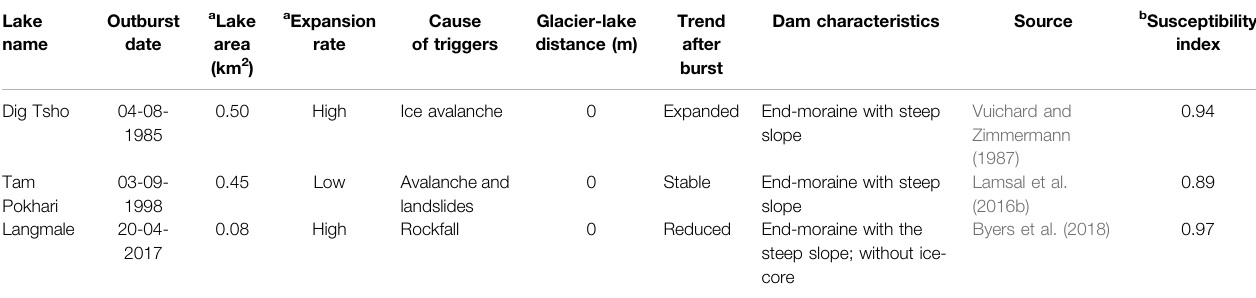
TABLE 2 | Characteristics of three well-known GLOF events in the Mahalangur